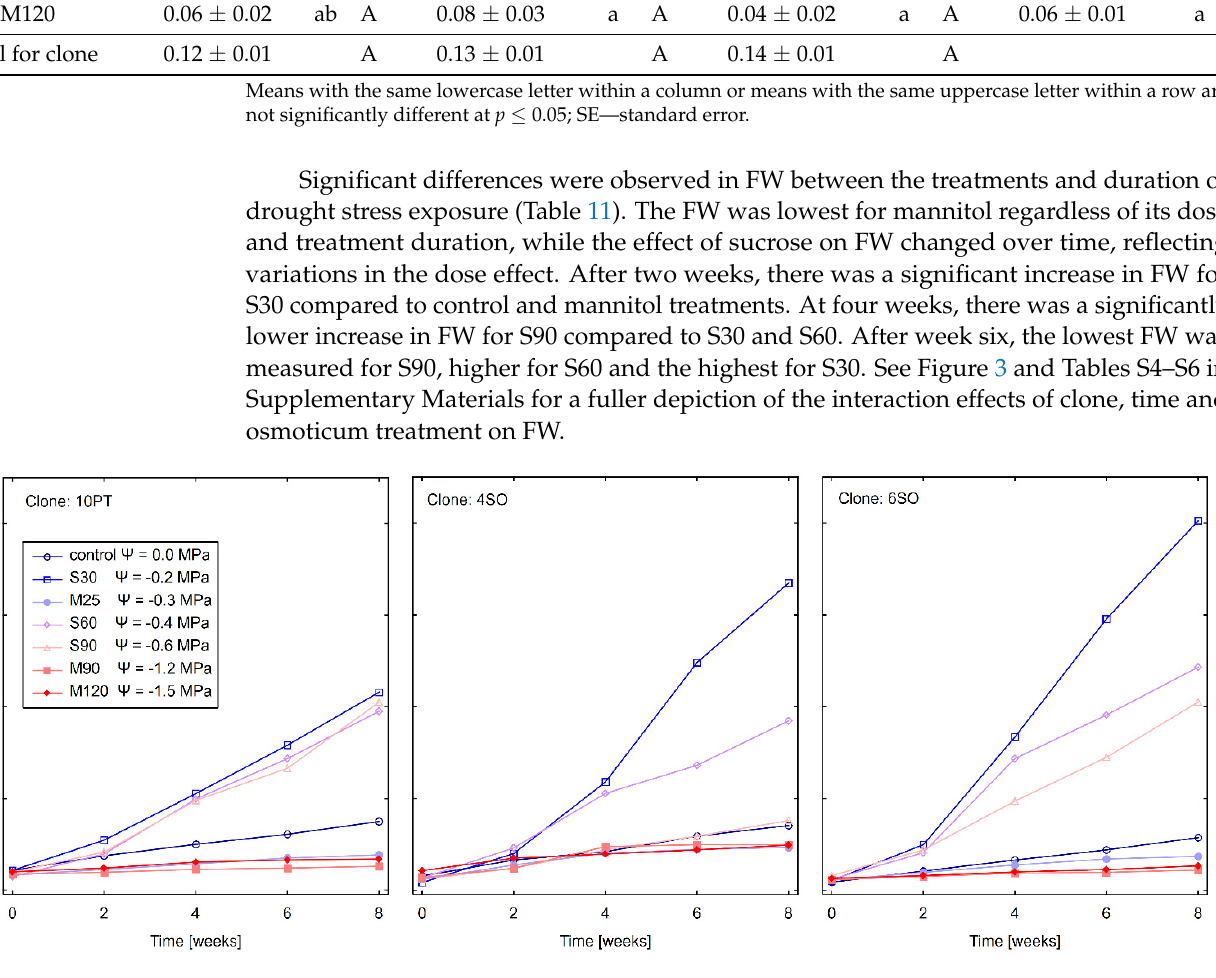
Figure 3. Effect of different osmoticum on fresh weight of R. pseudoacacia clones (10PT, 4SO, 6SO) for 8 weeks treatment. Different treatments are denoted: “control”—medium without osmoticum, “S30”—medium with 30 gL − 1 of sucrose, “S60”—medium with 60 gL − 1 of sucrose, “S90”—medium with 90 gL − 1 of sucrose, “M25”—medium with 25 gL − 1 of mannitol, “M90” medium with 90 gL − 1 of mannitol, “M120” medium with 120 gL − 1 of mannitol.